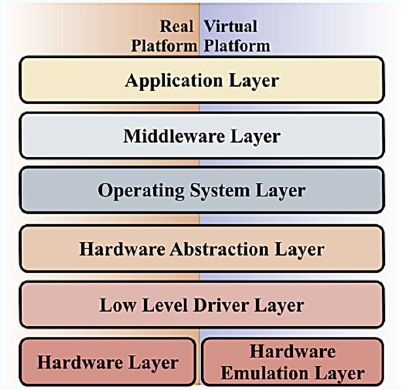
Figure 6. Typical architecture of embedded ‐ system ‐ software layers .